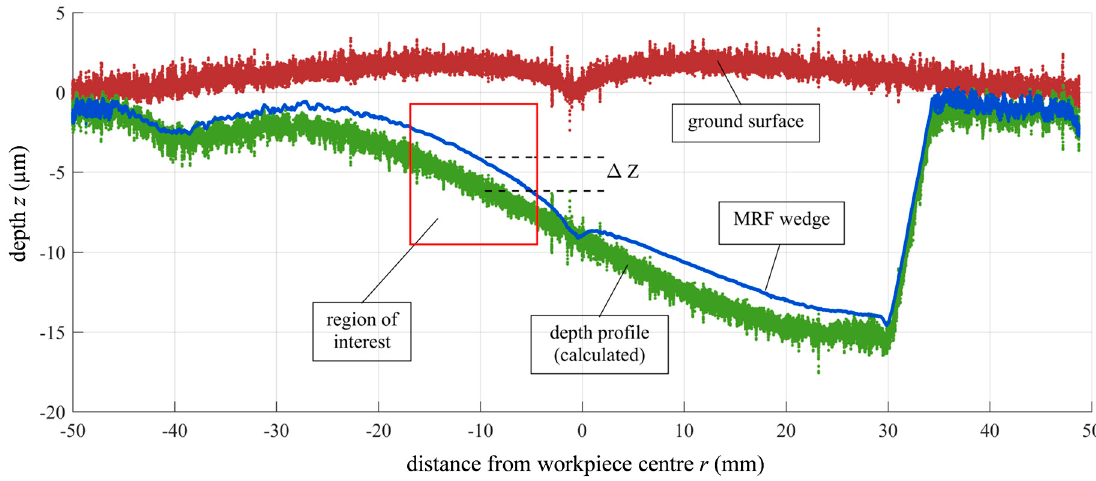
Figure 5. Tactile measurement of ground surface, MRF wedge and depth profile.